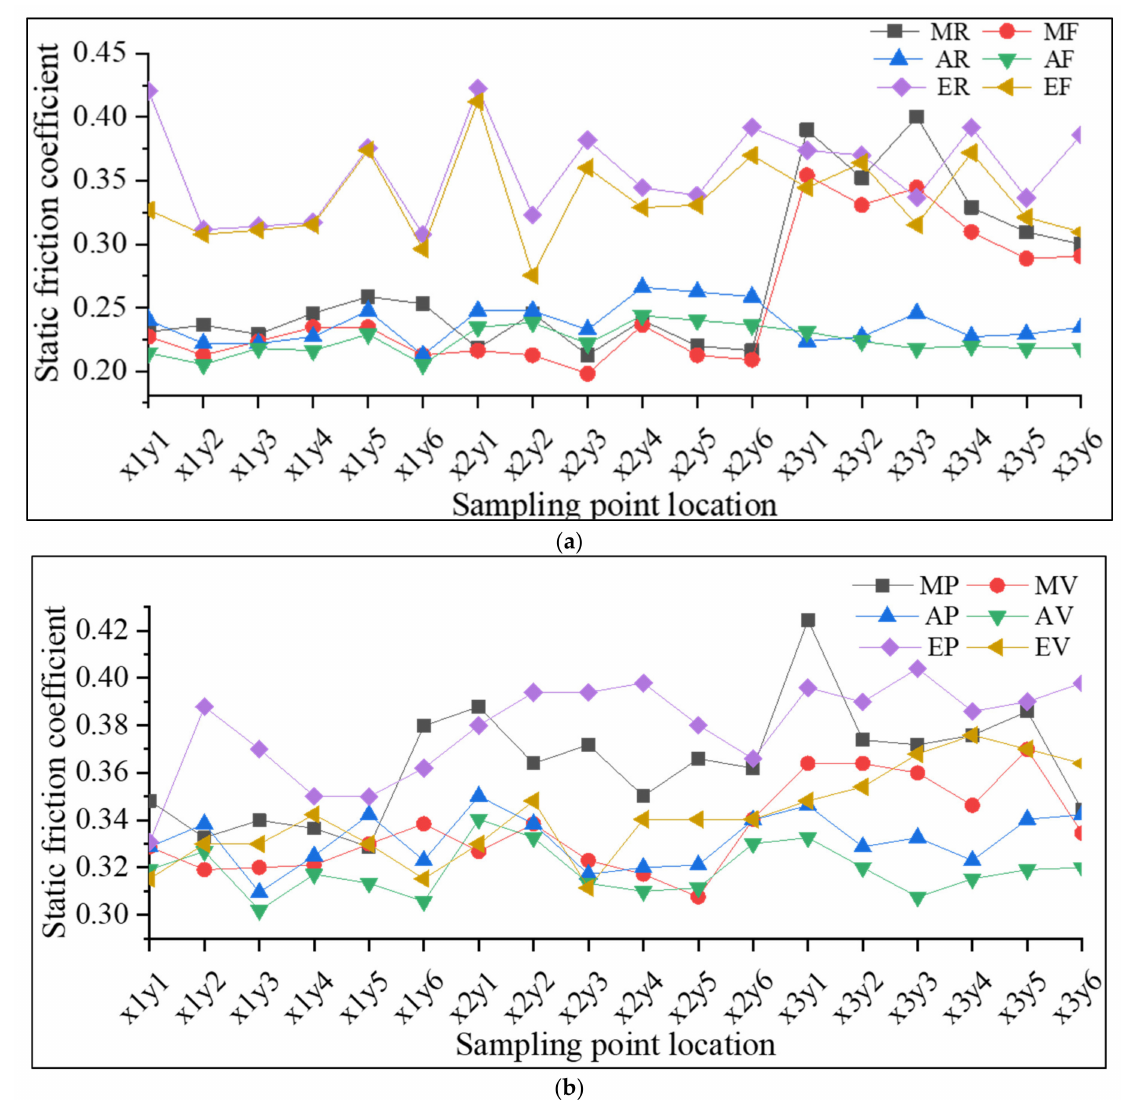
Figure 7. The static friction coefficient of the rice grains and stems for different contact configurations and in different measurement periods: ( a ) the awn points away from/in the movement direction; ( b ) the stem is placed parallel/perpendicular to the movement direction. MR, MF, AR, AF, ER, and EF; MP, MV, AP, AV, EP, and EV represent the combination of different periods (morning (M),/afternoon (A)/, and evening (E) and the awn directions regarding the movement directions (forward (F) and reverse (R) or the stem placement parallel (P) and perpendicular